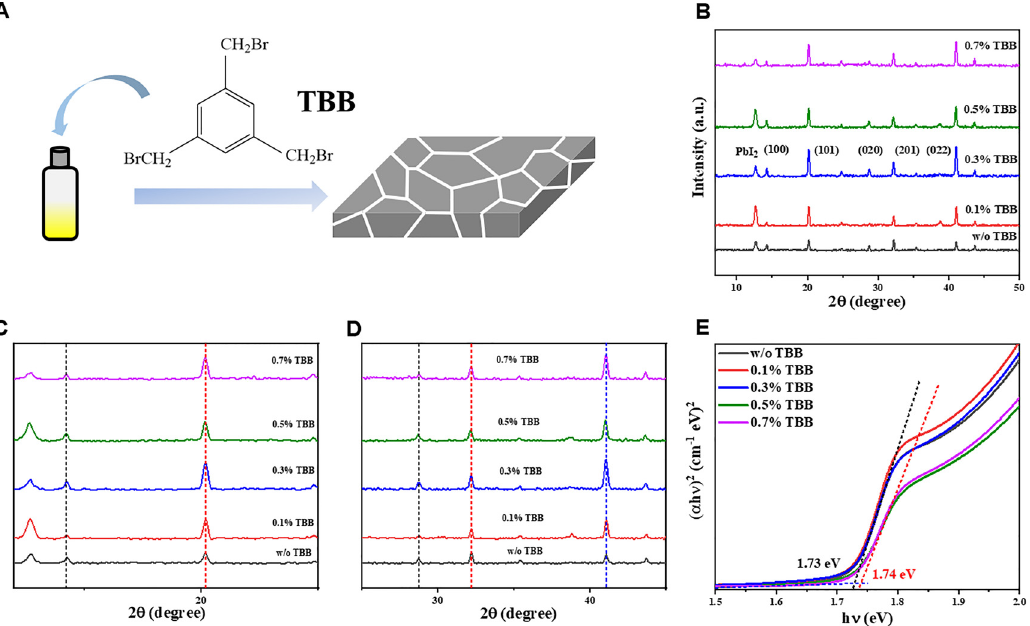
Figure 1: Diagram of 1,3,5-tris (bromomethyl) benzene (TBB)-doping, X-ray diffraction (XRD) patterns and optical properties of perovskite samples doped with different concentrations of TBB. (A) Chemical structure of TBB. (B) Full range of XRD patterns. (C, D) Magnified spectra of different 2 θ ranges. (E) Tauc